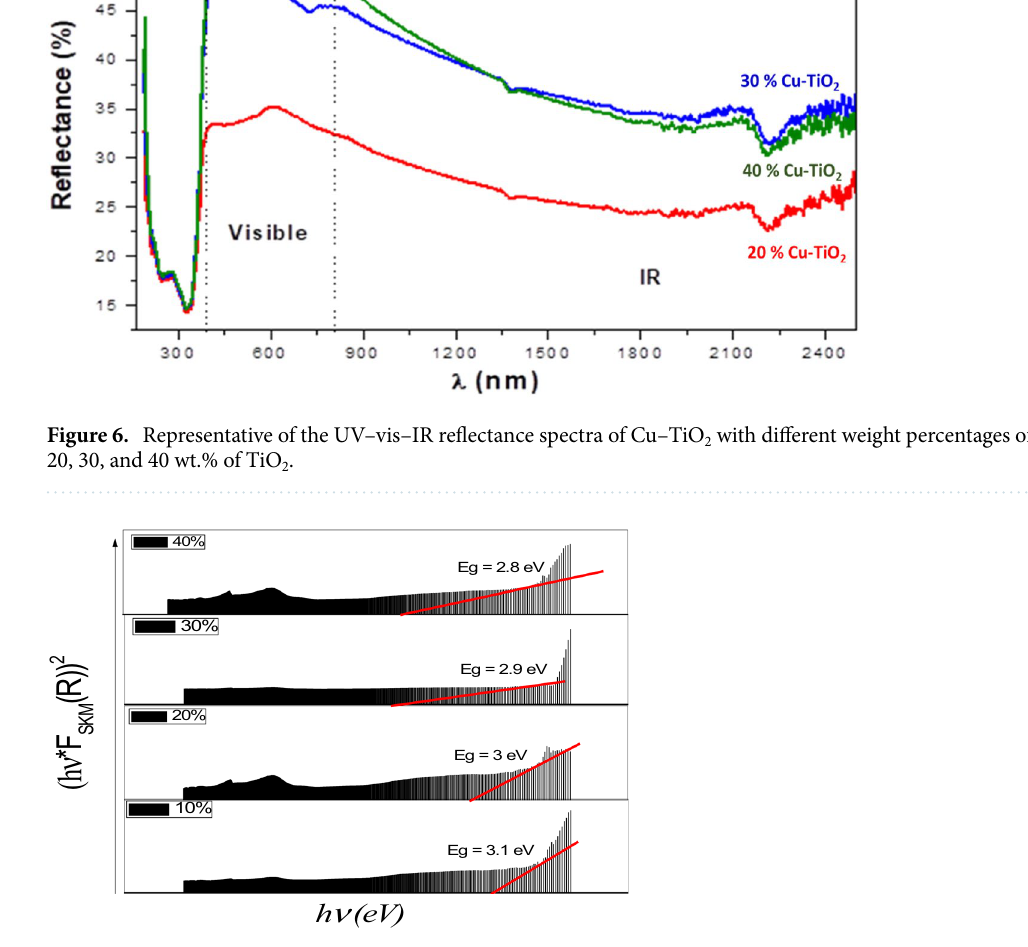
Figure 7. Representative the hvF SKM (R)) 2 vs. hv graphs of Cu-TiO 2 at different weight percent 10, 20, 30, and 40 wt.% of TiO